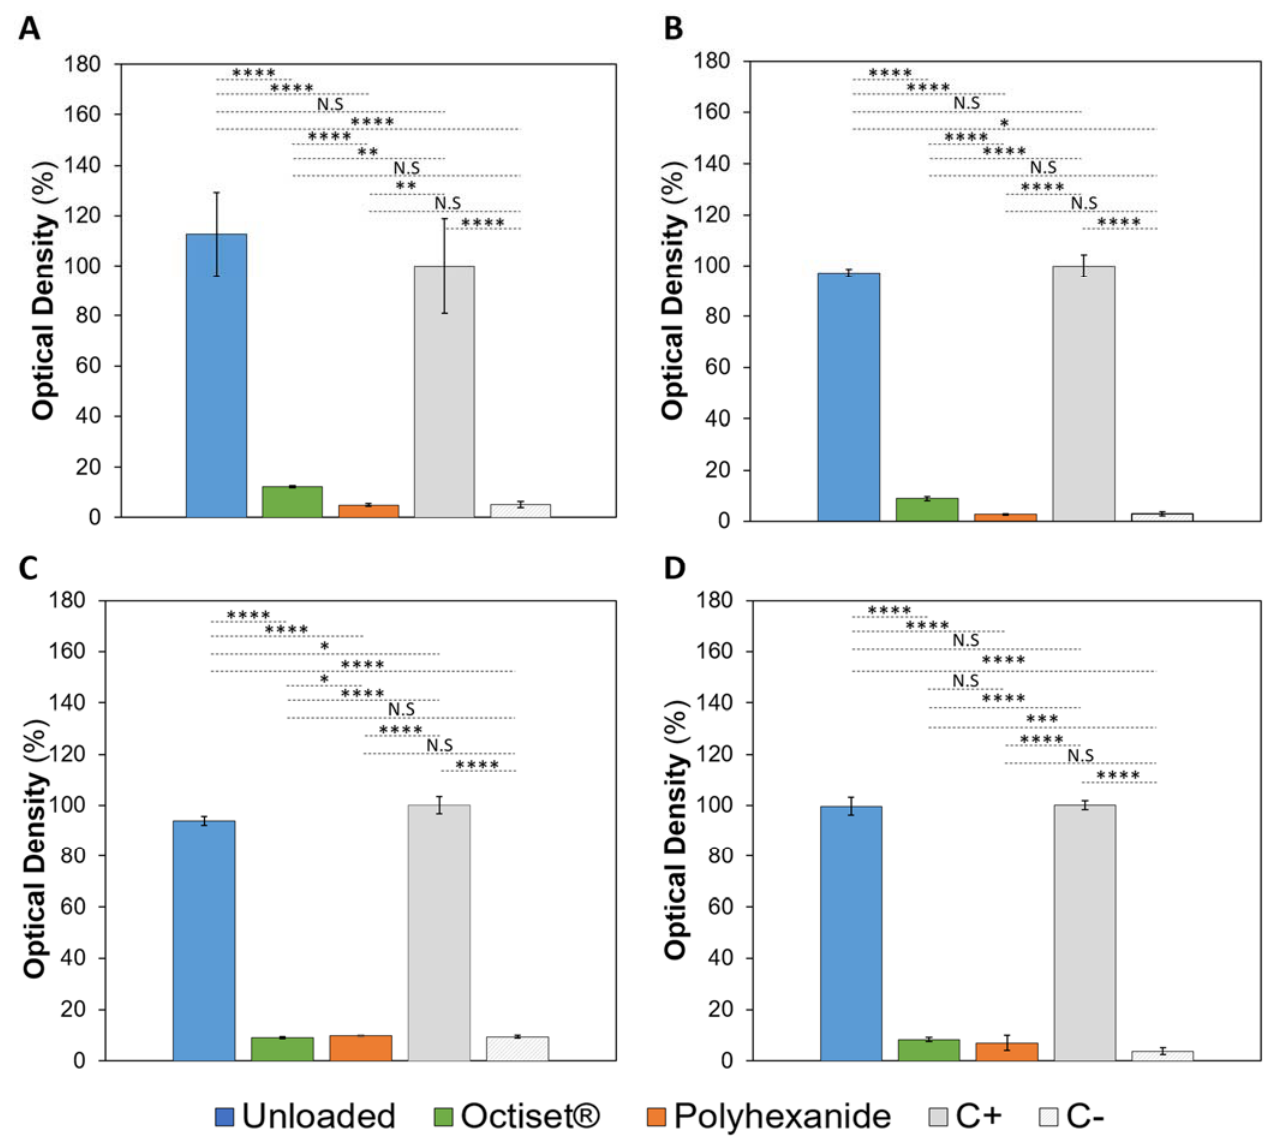
Figure 7. Optical densities of the incubation solutions containing Staphylococcus aureus ( A , C ) and Pseudomonas aeruginosa ( B , D ) and non-loaded and drug-loaded CS ( A , B ) and C ( C , D ) hydrogels. Positive (C+) and negative (C − ) controls are also present. The error bars correspond to ± standard deviations (n = 4). Statistical analysis was performed using the Student t -test or Wilcoxon signed-rank test, with significance set at * p < 0.05, ** p < 0.01, *** p < 0.005, **** p < 0.001. N.S. = not